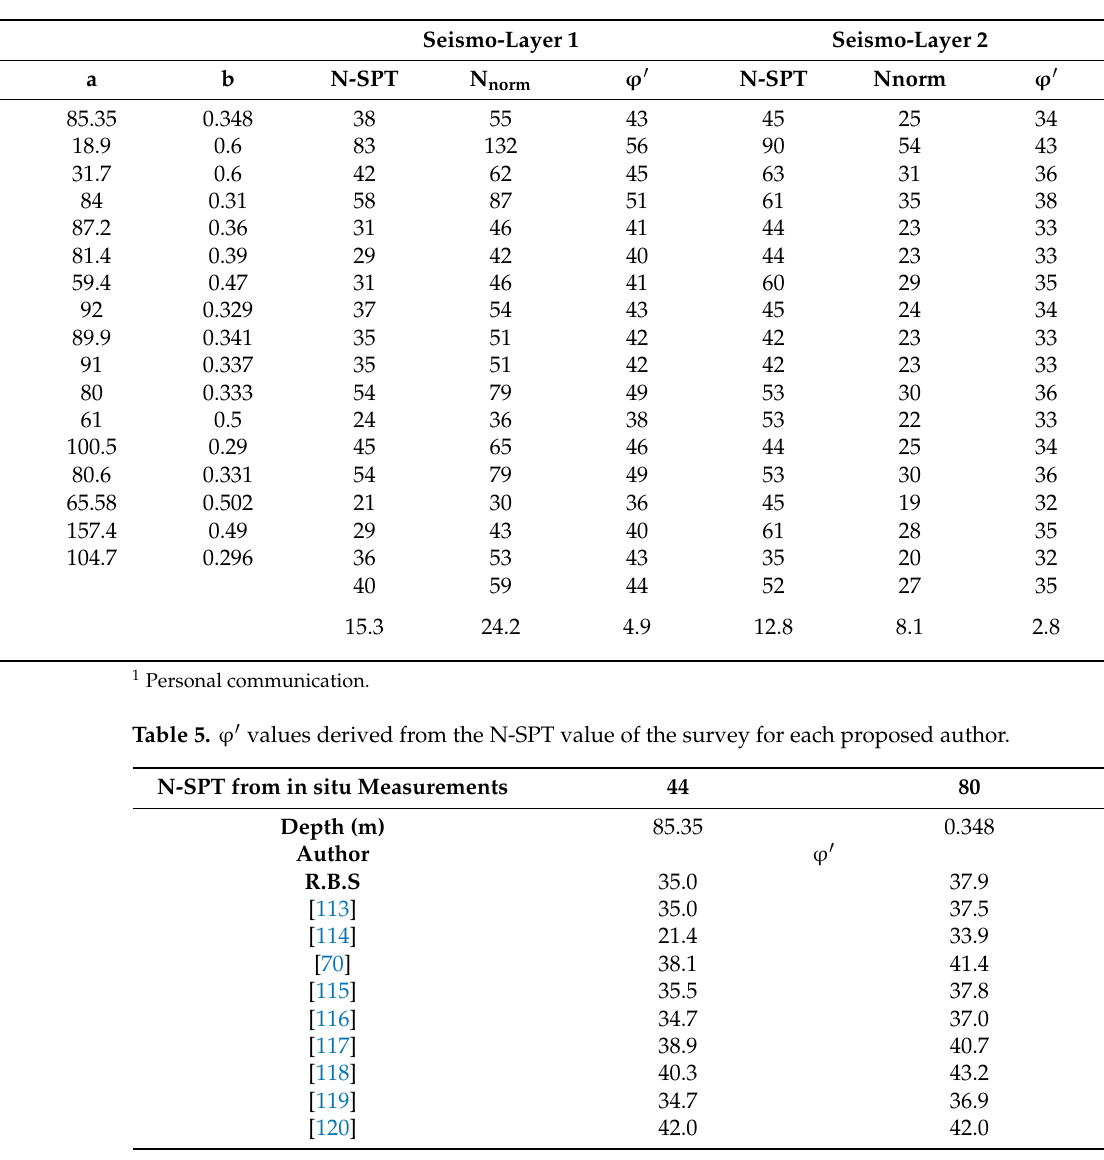
Table 4. Values of the coefficients a and b proposed by 17 different authors and used to estimate N- SPT. N norm indicates the normalised value of NSPT and ϕ (cid:48) is the value of the friction angle obtained for each value of N-SPT.